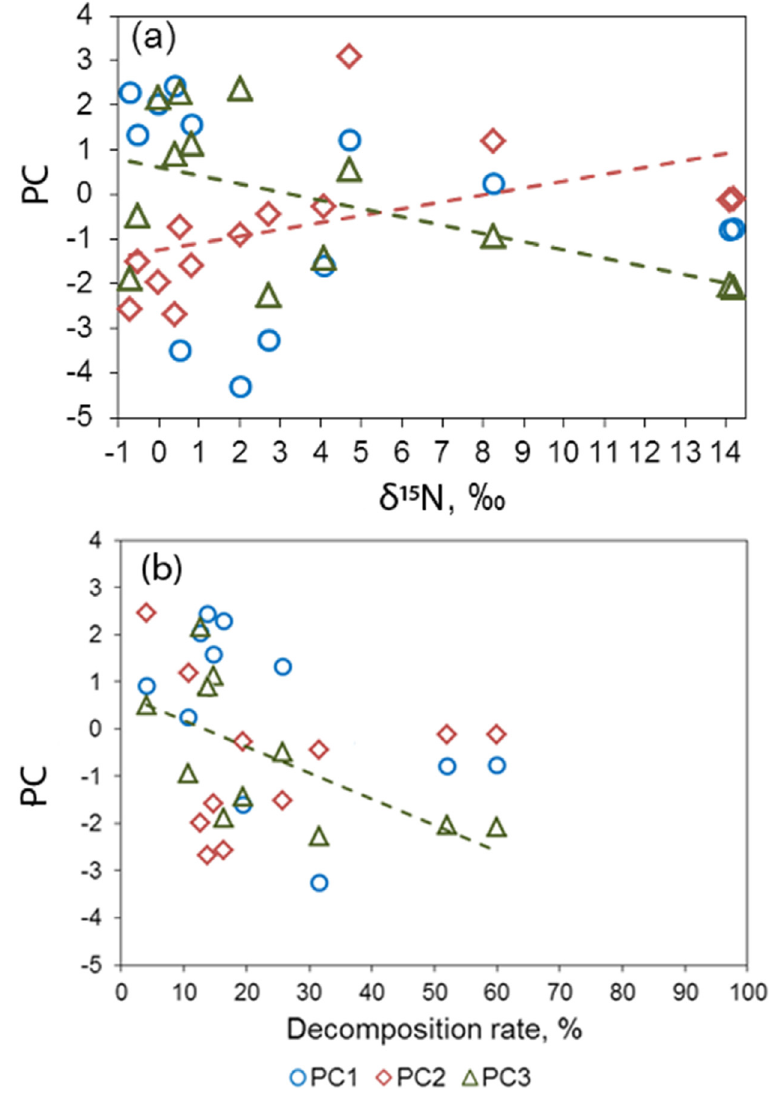
Figure 5. Regressions of the first three components on δ 15 N ( a ) and decomposition rate ( b ). Dashed lines show significant and close to significant relationships.